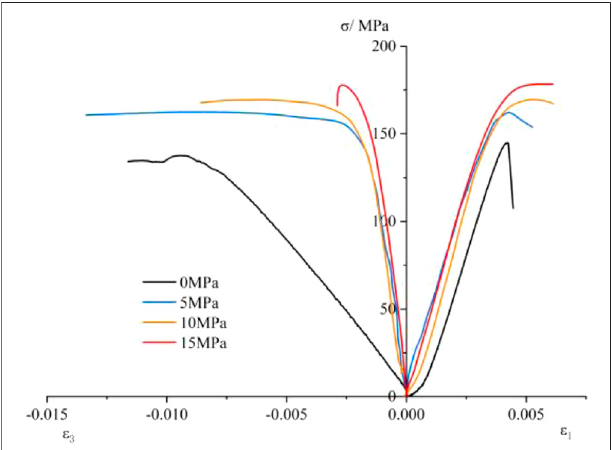
FIGURE 1 | Stress-strain curves of Jinping marble